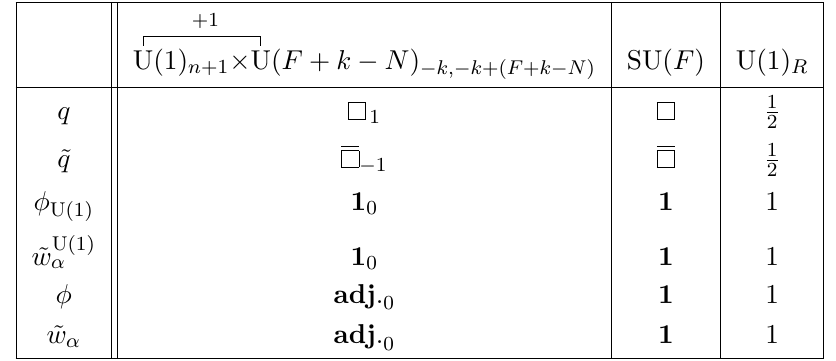
Table 2 . The magnetic